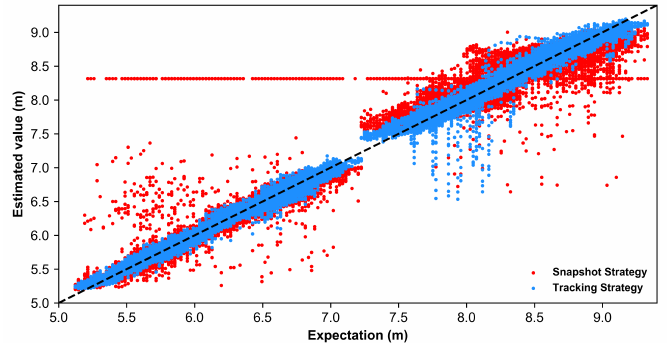
Figure 9. The distribution of the estimated values by the snapshot-based model and tracking-based model. As can be seen in the figure, a group of fixed false estimated points (red) occurred at ∼ 8.3 m, perhaps caused by a fixed noisy target within the blast furnace